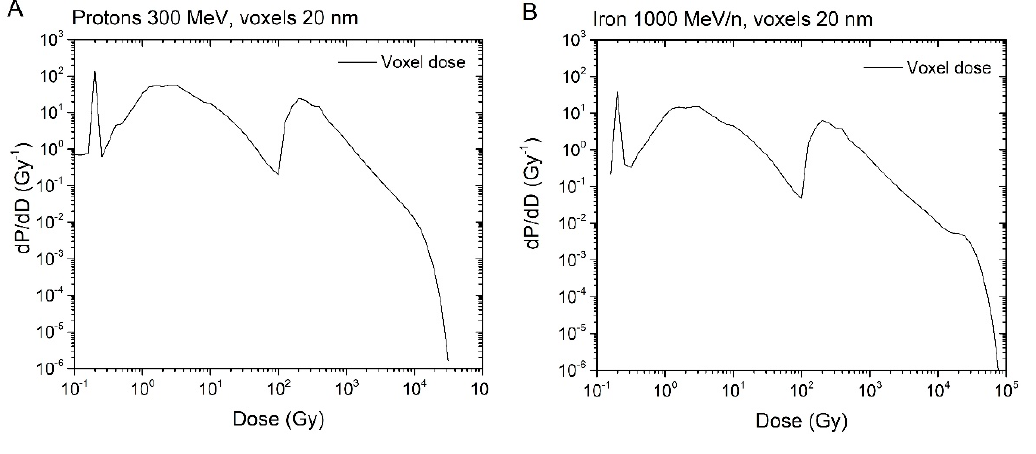
Figure 3. Dose distribution (dose per voxel) for 300 MeV protons ( A ) and 1000 MeV/n iron ions ( B )